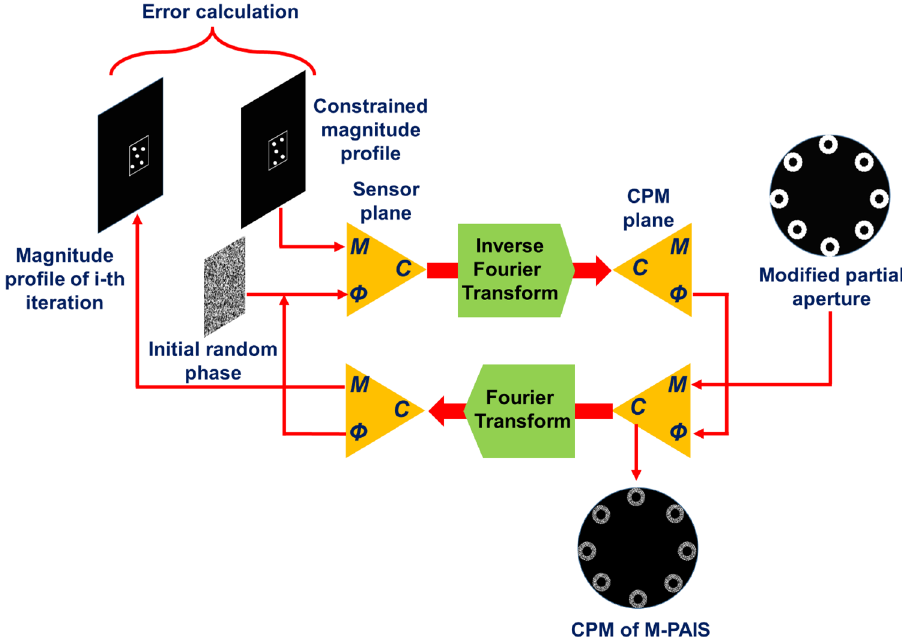
Figure 3. Gerchberg–Saxton algorithm for M-PAIS CPM